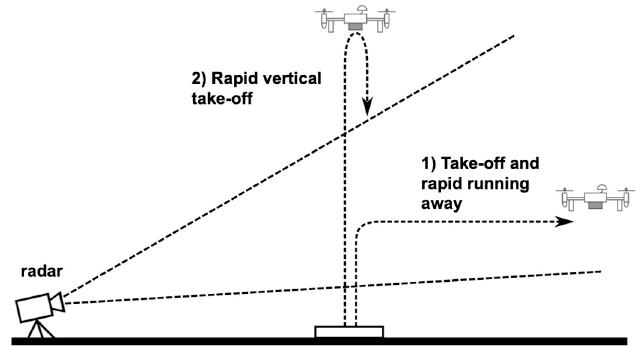
Figure 16. Two different flight maneuvers: ( 1 ) take-off and rapid running away and ( 2 ) rapid vertical take-off.